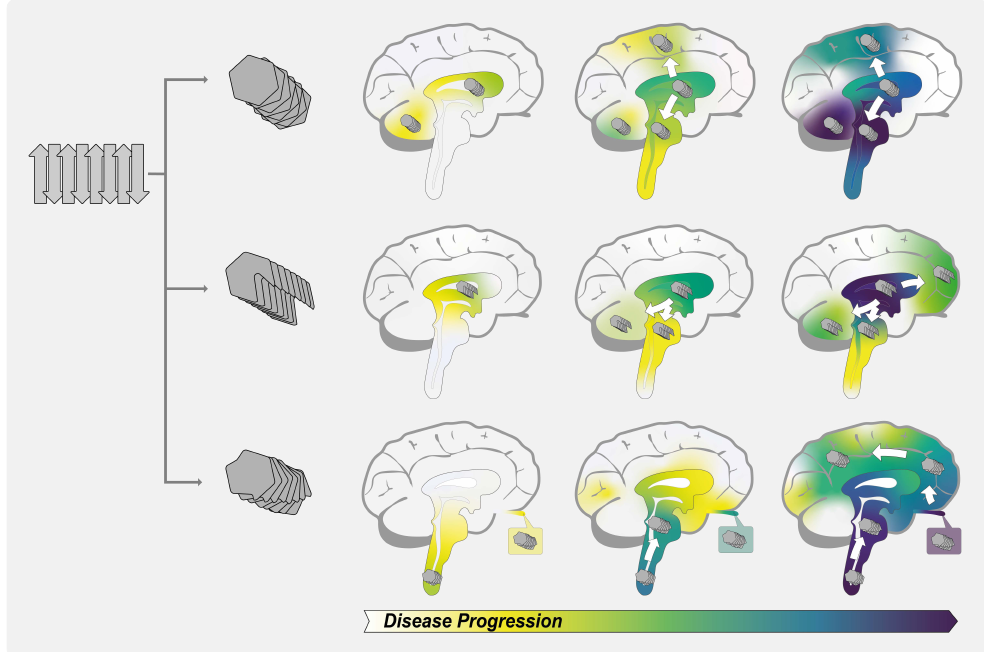
Figure 3. Graphical representation of α -Syn deposition patterns during the progression of various synucleinopathies based on conformation. Pathogenic α -Syn can adopt different conformations with different fibril architectures. According to the prion strain hypothesis, each synucleinopathy would be caused by a distinct α -Syn amyloid conformational variant or strain. Each strain has a distinct spreading pattern and associated neuropathology, resulting in different disease phenotypes in the respective patients. Synucleinopathy-specific α -Syn inclusions and cellular damage would accumulate to a characteristic extent in particular areas of the brain over the course of the disease (yellow/mild →